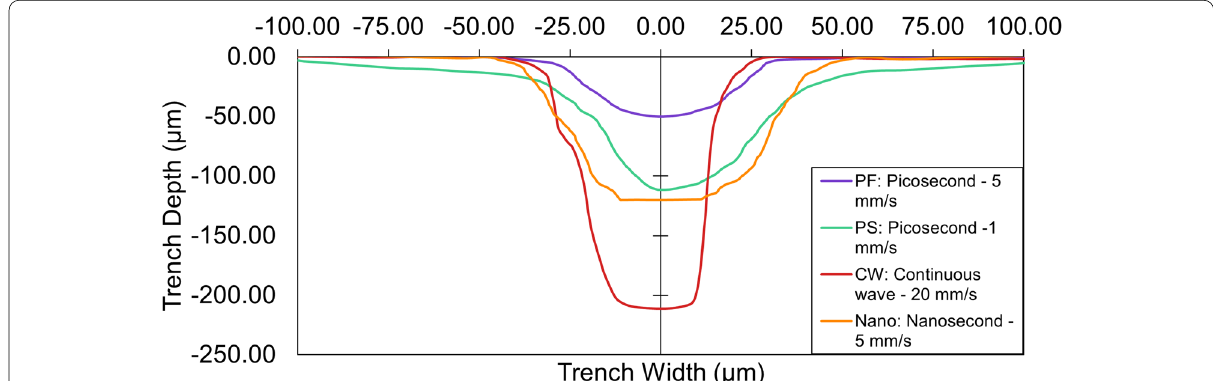
Figure 5 Mean cross‑sectional trench profile: the mean cross‑sectional trench profiles were plotted for samples machined with identical process parameters as those used in the histological